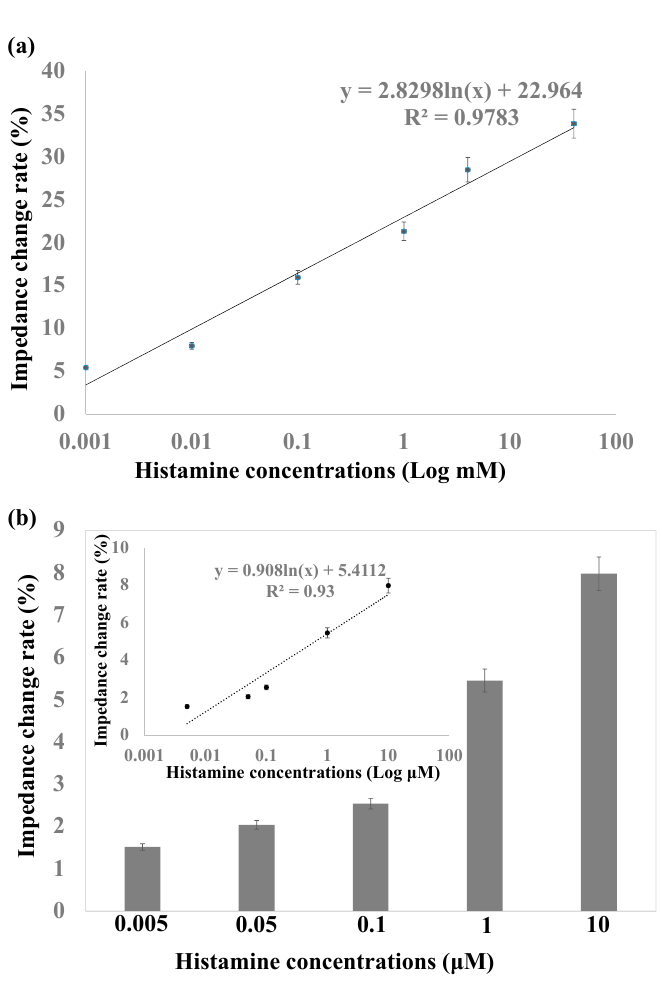
Figure 6. ( a ) Linear relationship between impedance change rate versus histamine concentrations from 1 µ M to 100 mM; ( b ) Impedance change with histamine concentrations from 5 nM to 10 µ M.